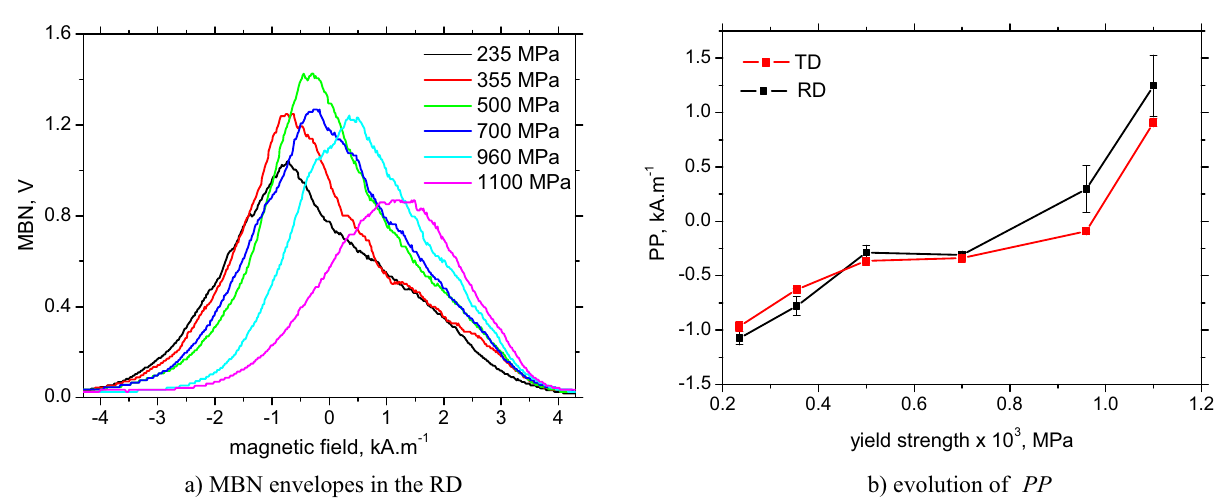
Figure 14. MBN envelopes in the RD and evolution of PP